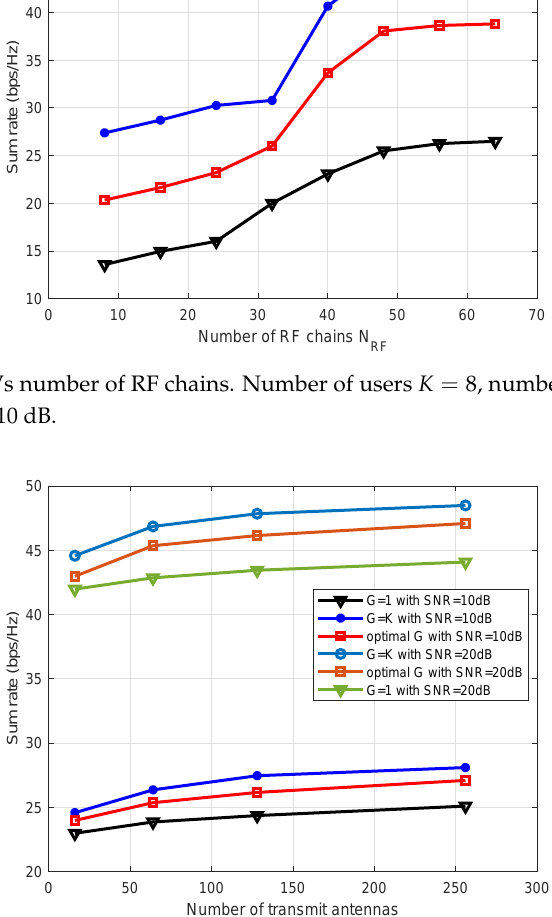
Figure 12. Sum-rate Vs number of transmit antennas. The number of RF chains at BS is fixed at 8, number of users is 8 and the results are obtained for SNR = 10 dB and SNR = 20